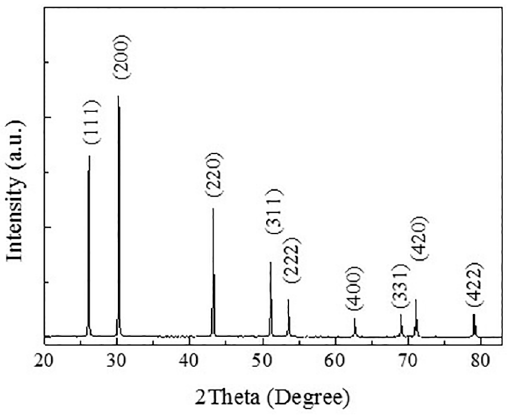
Figure1: XRD patterns of PbS